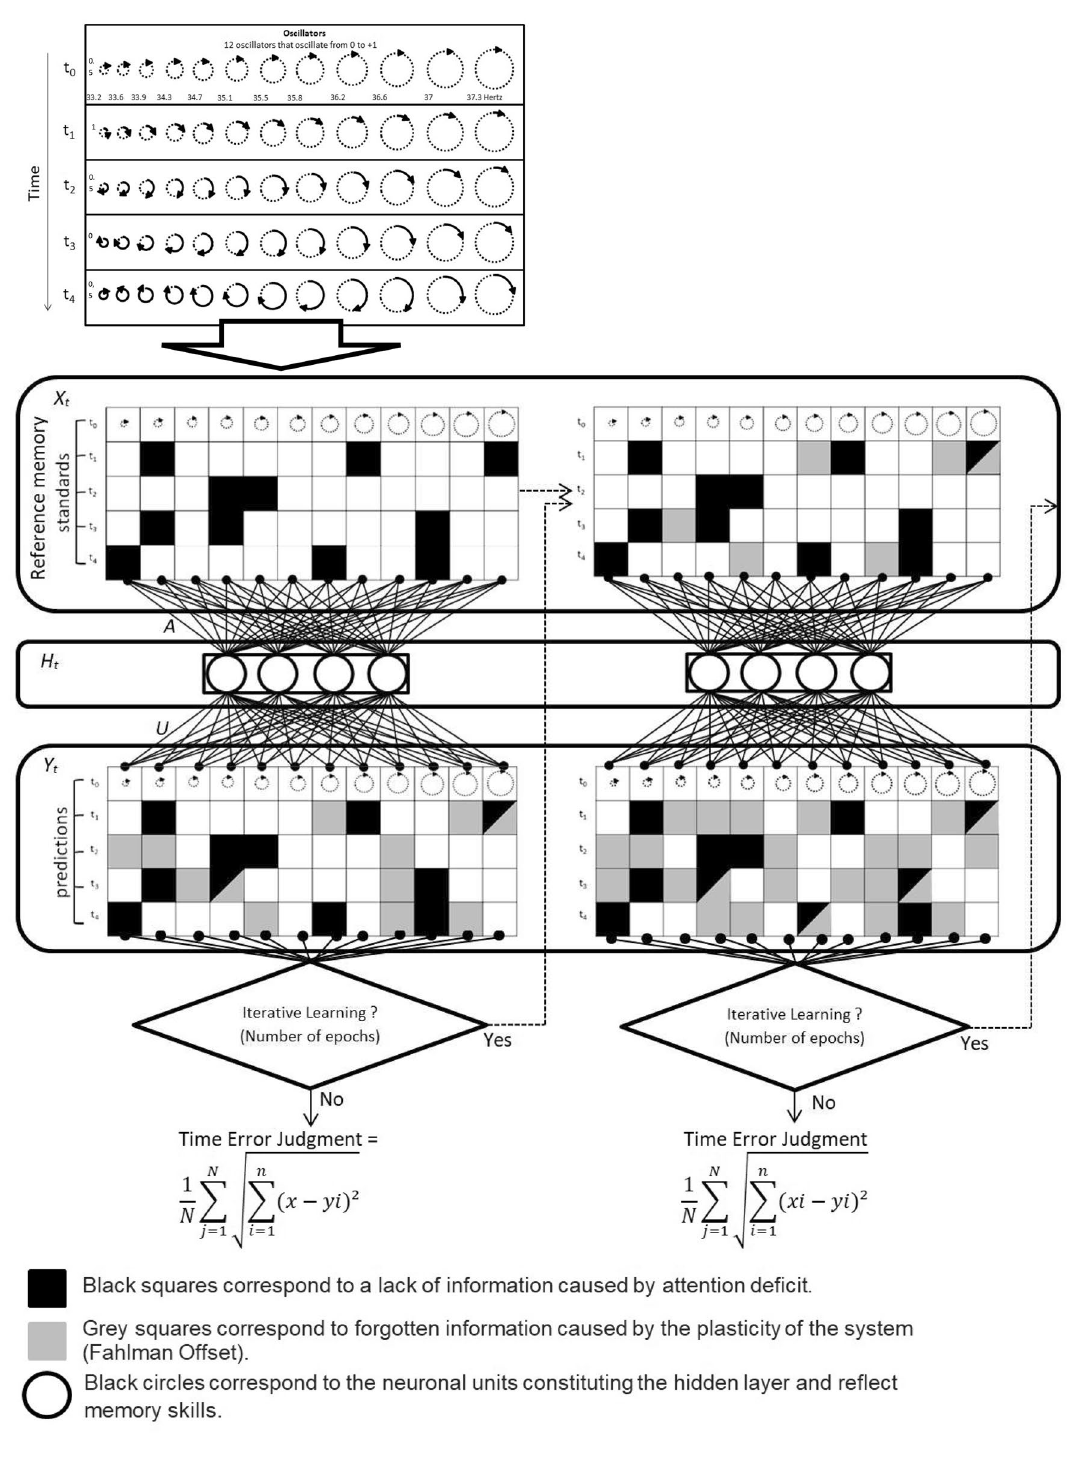
Figure 4. Simplified illustration of Cognitive and Plastic RNN clock model (CPC model). The first table shows the oscillation over time (from 0 to 1) of 12 neuronal oscillators. The oscillation information is more or less integrated according to subjects’ attentional capacities. An attention deficit generates a lack of information for a given time and a given oscillator (represented in the graph by black squares). The information held with respect to these oscillators is then combined into a memory system so it can generalise the anchored information. The information that springs out of this structure corresponds to the temporal estimation of the subject, to which gray squares have been added, corresponding to forgetfulness. The proportion of forgetfulness corresponds to plasticity (Fahlman offset), since a more plastic system learns faster but also forgets more easily. Finally, the subject can give an estimate which corresponds to the cumulative average of the Euclidean distance averages of the objective—subjective differences. Nevertheless, in the case of iterative temporal learning, the whole operation will be restarted. Further, predictions will increasingly suffer from the weight of the prior estimation, which will scramble the initial standard duration, thus increasing the proportion of noise in the reference